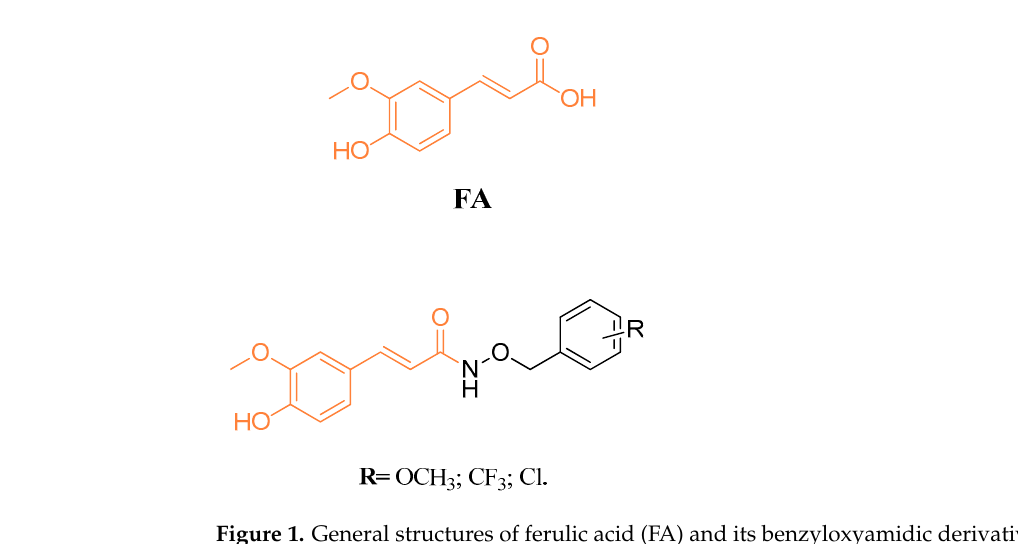
Figure 1. General structures of ferulic acid (FA) and its benzyloxyamidic derivatives.